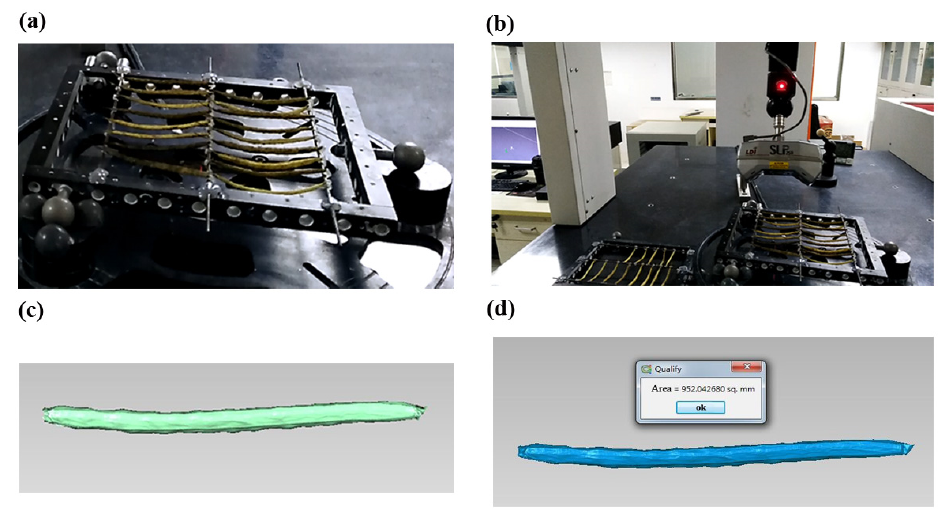
Figure 8. Scanning of rapeseed pods using a 3-D laser scanning system and the data processing process: ( a ) Pod scanning fixture; ( b ) Process for the 3-D laser scanning system to scan pods; ( c ) Pod selection; ( d ) Calculation of the pod surface area.